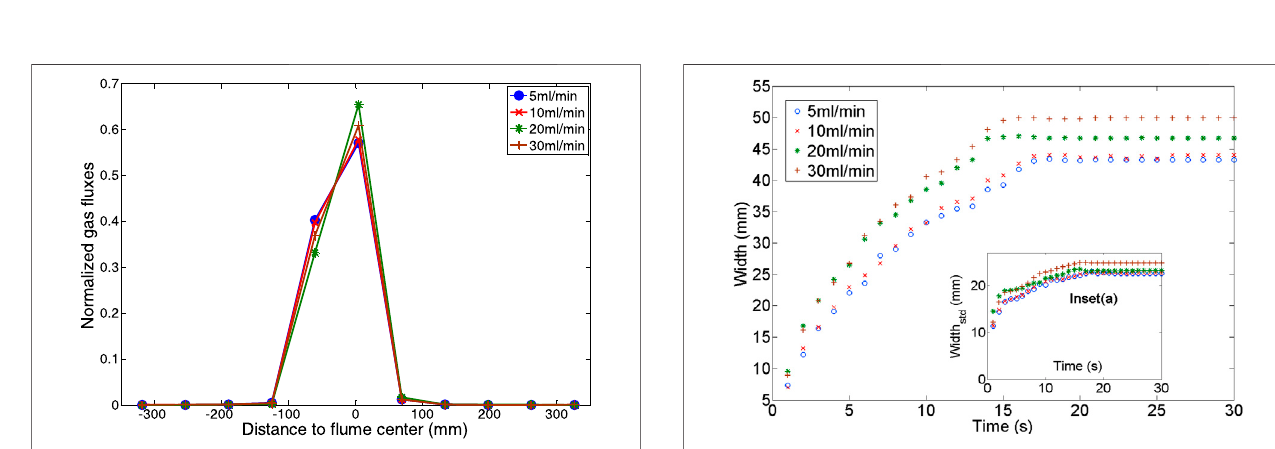
FIGURE 5 | Normalized gas fl uxes at the top boundary of the domain based on the simulation outcomes.